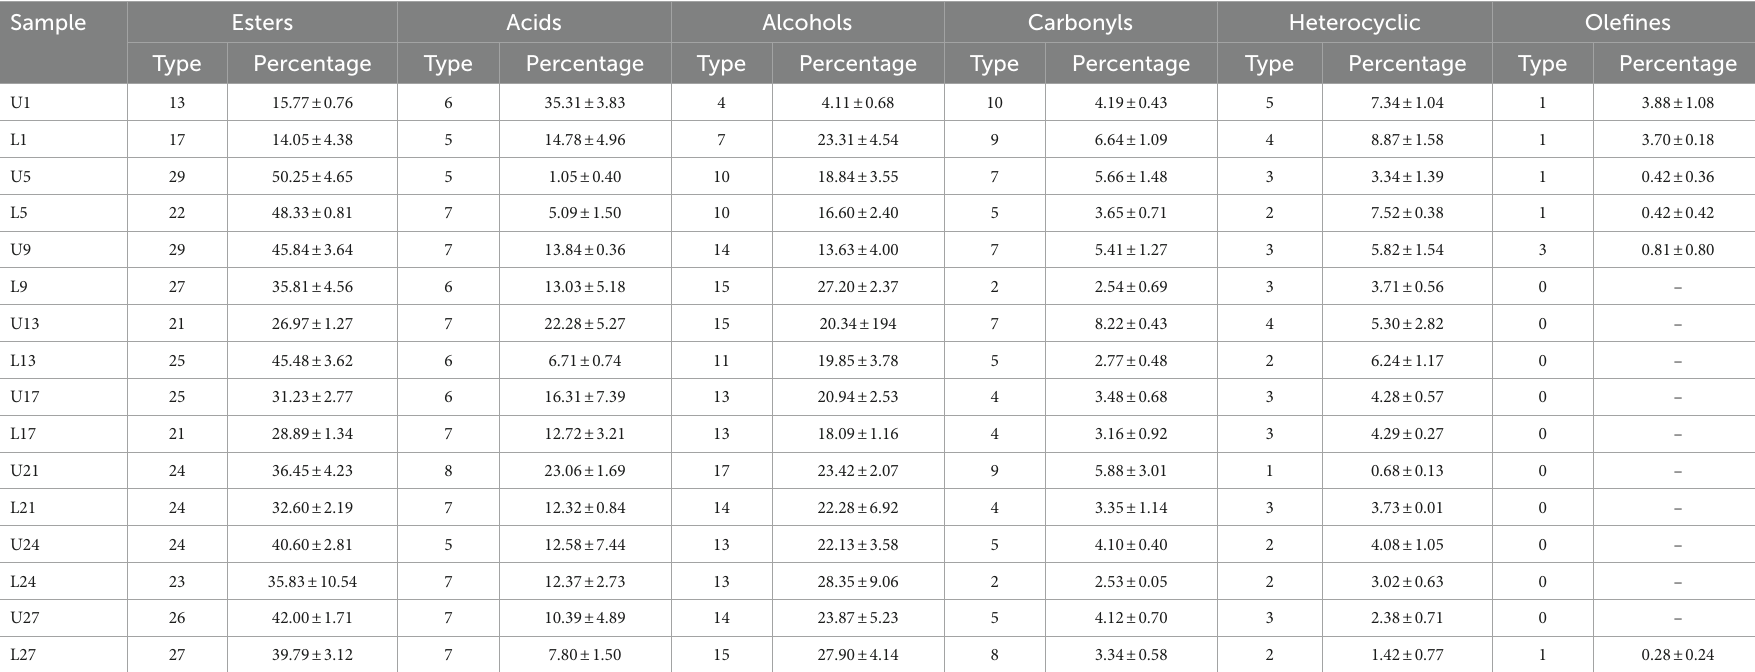
TABLE 1 Number of volatile flavor compounds and their relative percentage composition (n/%) during vinegar